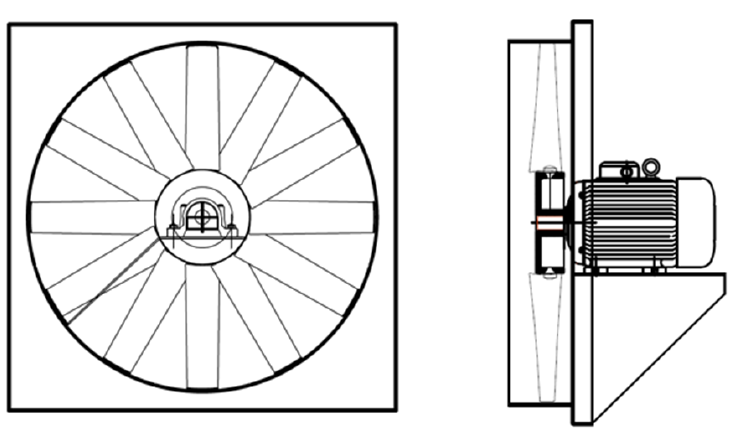
Figure 2. Axial fan scheme (front and side view).